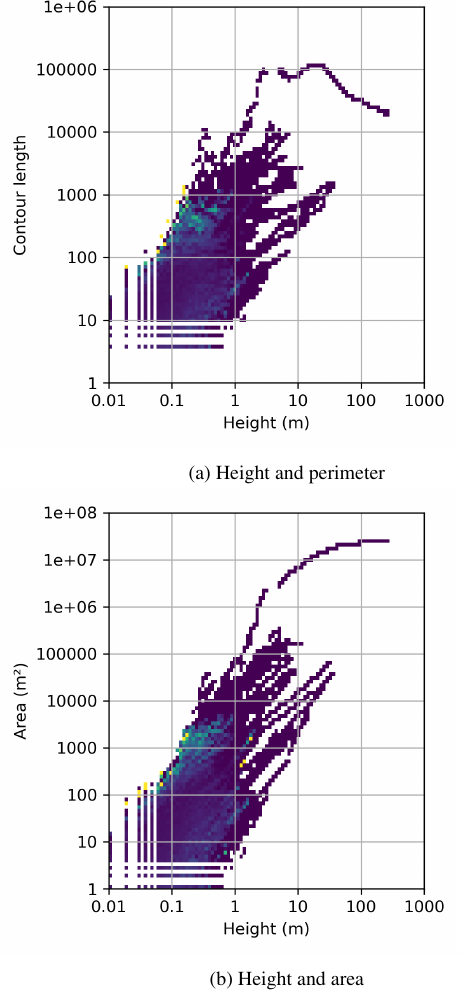
Figure 5. Activation maps of pattern spectra over the gold panning areas with the min-tree. The bin color represents the percentage of nodes defined as gold panning in the global spectrum. Values range from 0% (purple) to 100%